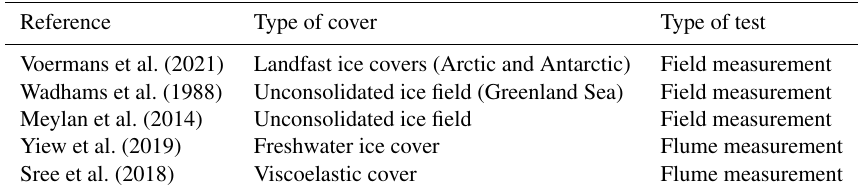
Table 1. Cases studied in the present